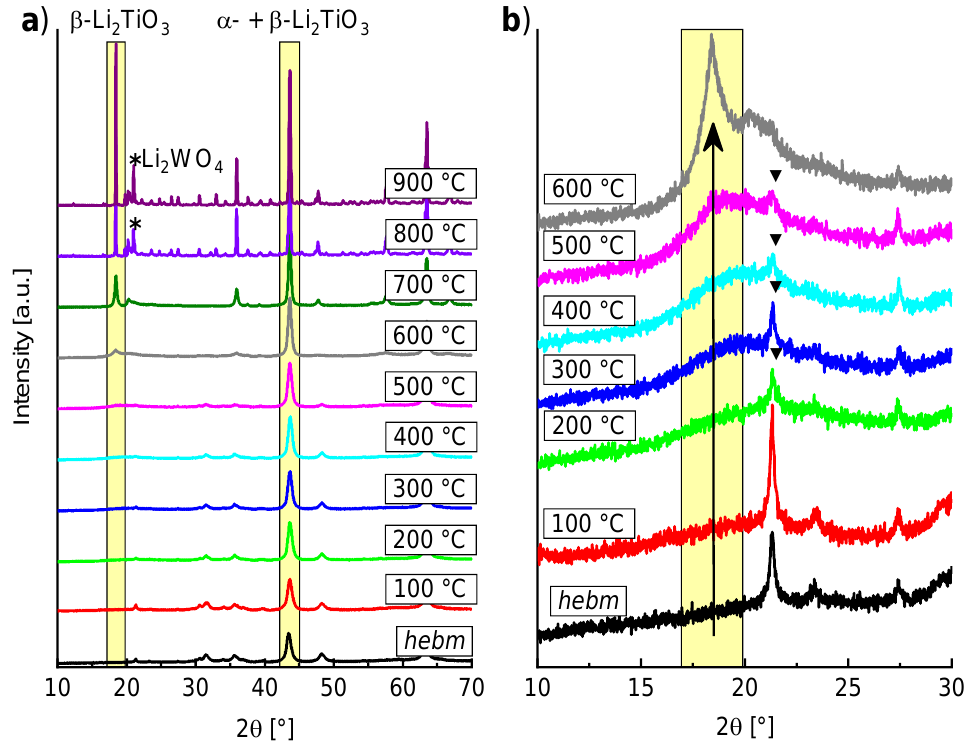
Figure 5. PXRD measurements of high energy ball milling ( hebm ) Li 2 TiO 3 after heating to different temperatures for 1 h. ( a ) Main reflections of β - and α -Li 2 TiO 3 are highlighted; ( b ) The arrow indicates the deployment of the (002) reflection of β -Li 2 TiO 3 between 500 and 600 °C. Triangles indicate the main reflection of Li 2 CO 3 .